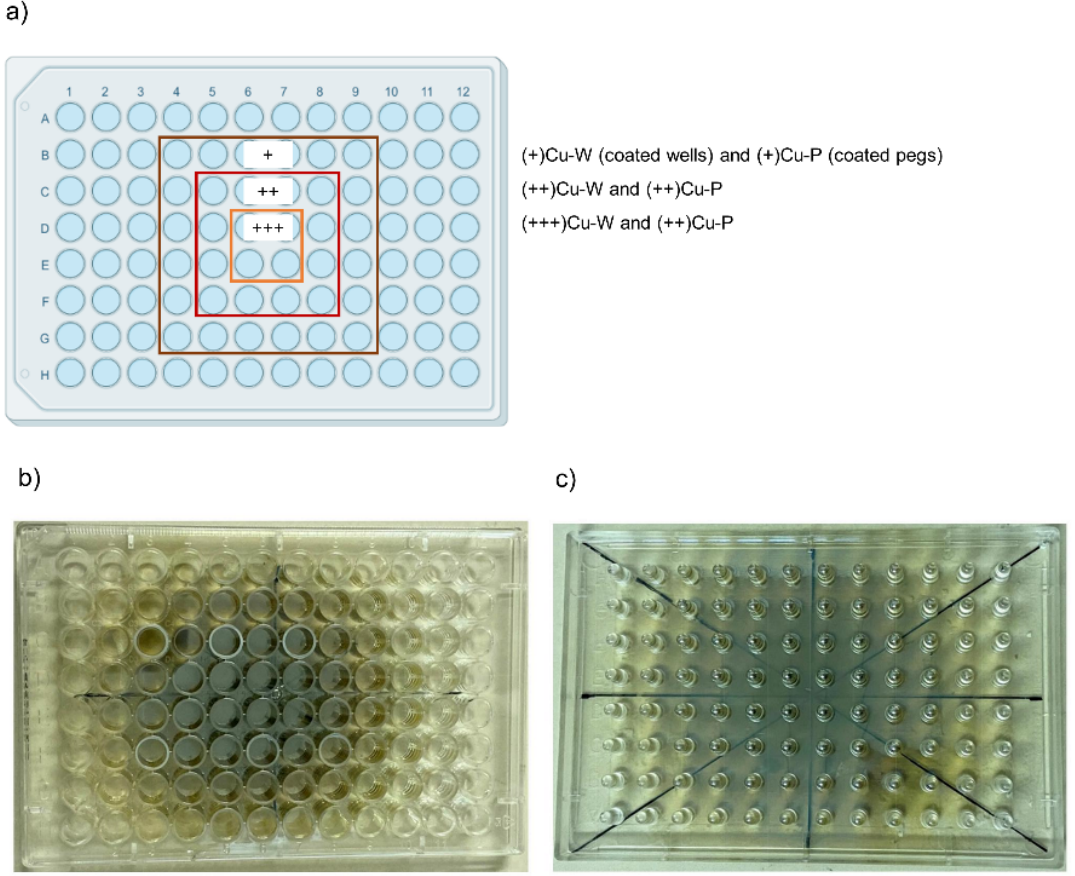
Figure 1. The three areas ( a ) on the Calgary Biofilm Device coated with copper on wells ( b ) and pegs ( c ). The boxes containing the indication (+)Cu, (++)Cu, and (+++)Cu correspond to the wells/pegs in the CBD areas that have coatings with the same concentrations, i.e., low Cu concentration for (+)Cu, medium Cu concentration for (++)Cu, and high Cu concentration for (+++)Cu.